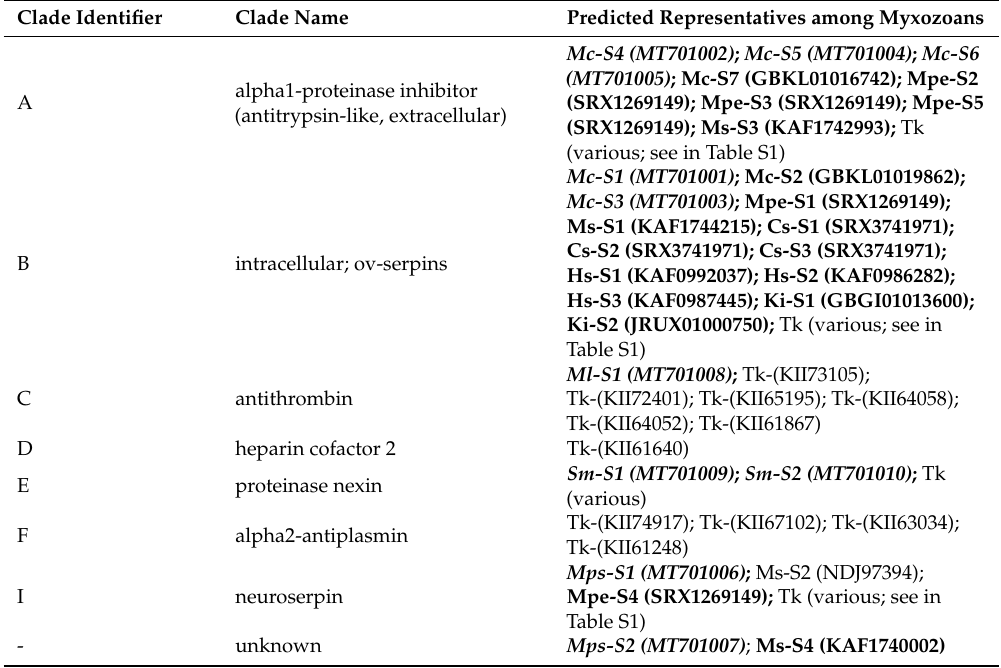
Table 1. Examined myxozoan serpins, classified according to Gettins [19]. The typing was conducted using UniProt BLAST and Merops-MPEP. Further details are available in Table S1. GenBank accession numbers are after serpin names in parenthesis. Bold: newly identified serpin-homologs; bold-italics: new sequence additions to